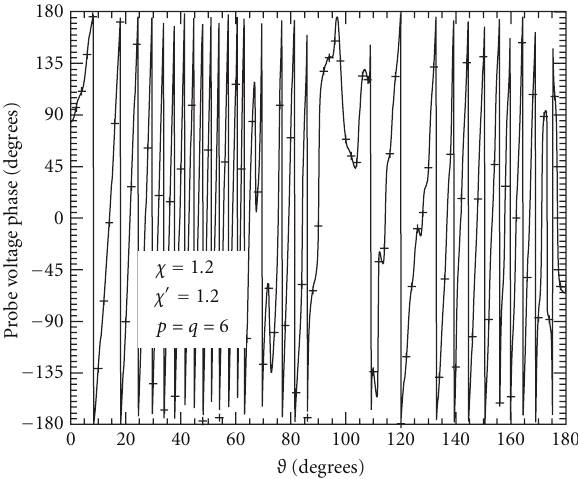
Figure 6: Phase of the output voltage V (cid:2) on the meridian at ϕ = 90 ◦ . Solid line: exact. Crosses: